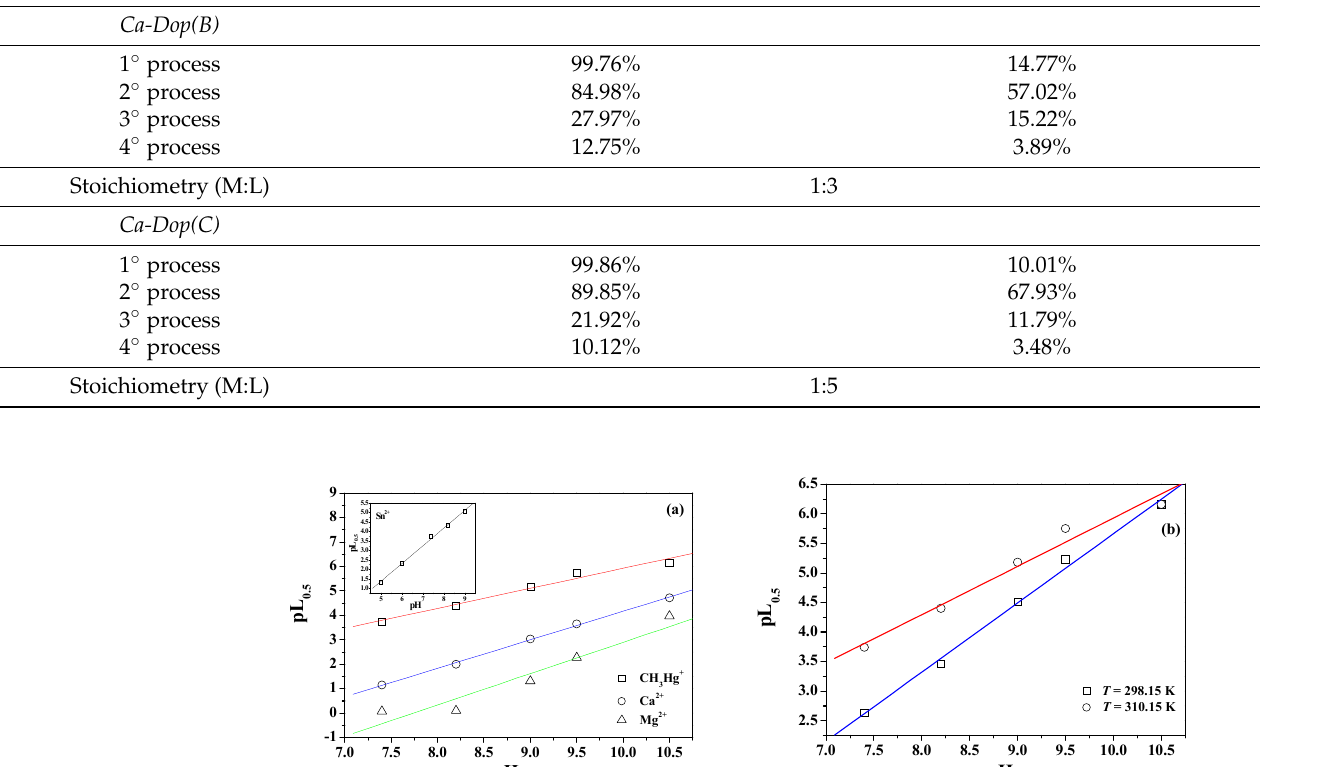
Table 14. Empirical parameters for the modeling of pL 0 . 5 values of the metal/dopamine systems with respect to T /K, I /mol dm − 3 and pH.